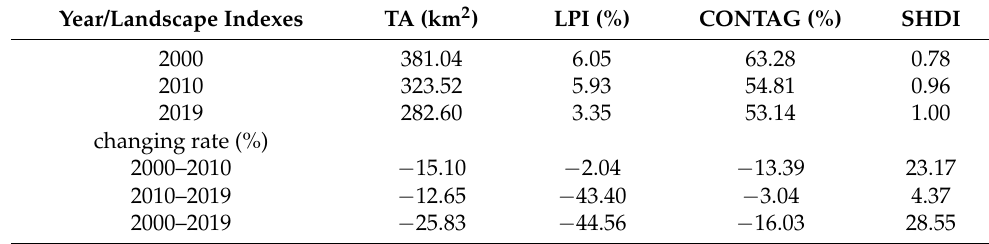
Table 2. Landscape indexes of green space in the central city from 2000 to